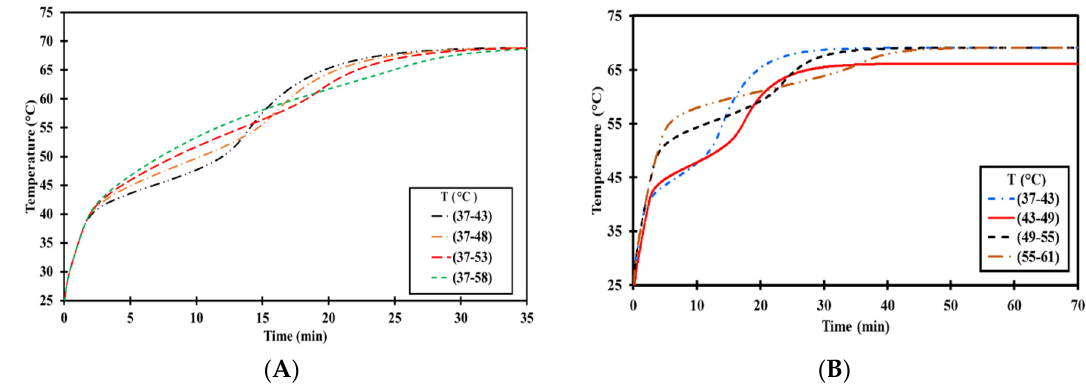
Figure 14. The effect of PCM melting characteristics on the HS temperature drop: ( A ) with a fixed start of melting and increasing melting range; and ( B ) with a fixed melting range and shifting melting start.